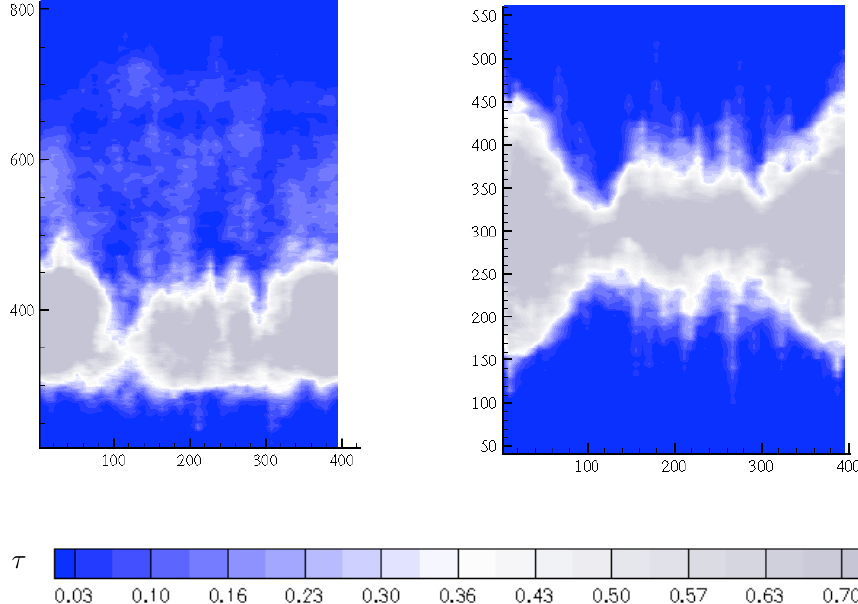
Fig. 13. Two-dimensional distributions of the optical depth τ in the xz plane (left panel) and xy plane (right panel), obtained by integration of Eq. (17) over the horizontal and vertical directions, respectively ( t = 320s, run V D 1).